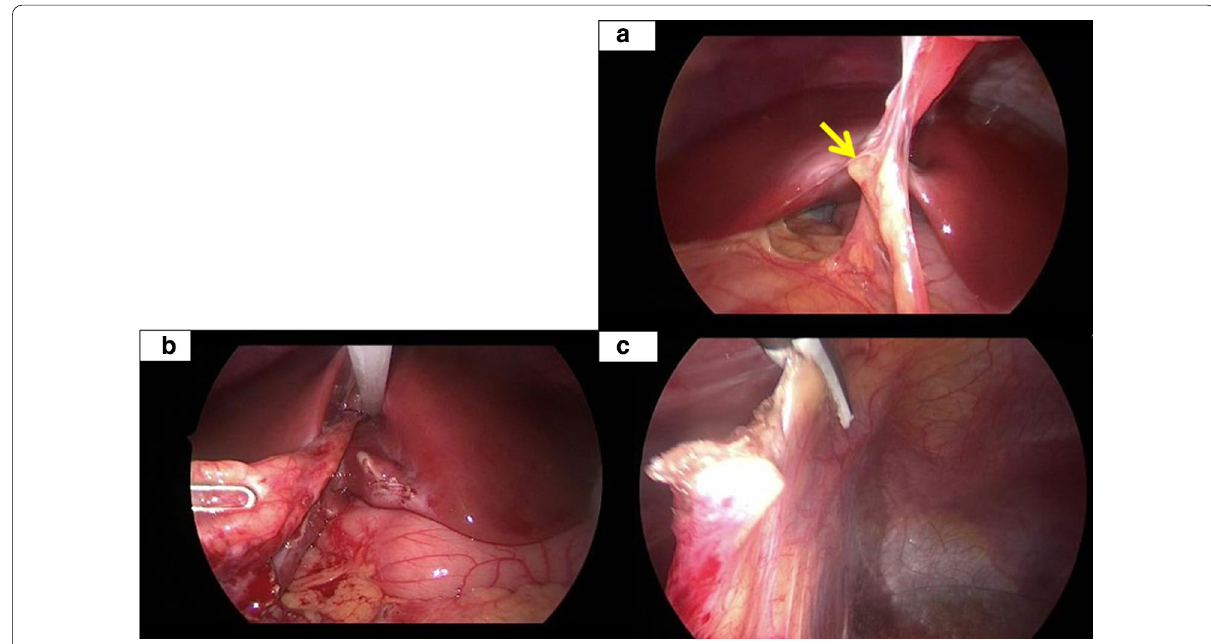
Fig. 3 Operative findings. a The omentum was adherent to the round ligament of the liver. The arrow points the ALL. b Resecting adhesion from around the round ligament of the liver. c Ligation of the round ligament of the liver attached to the